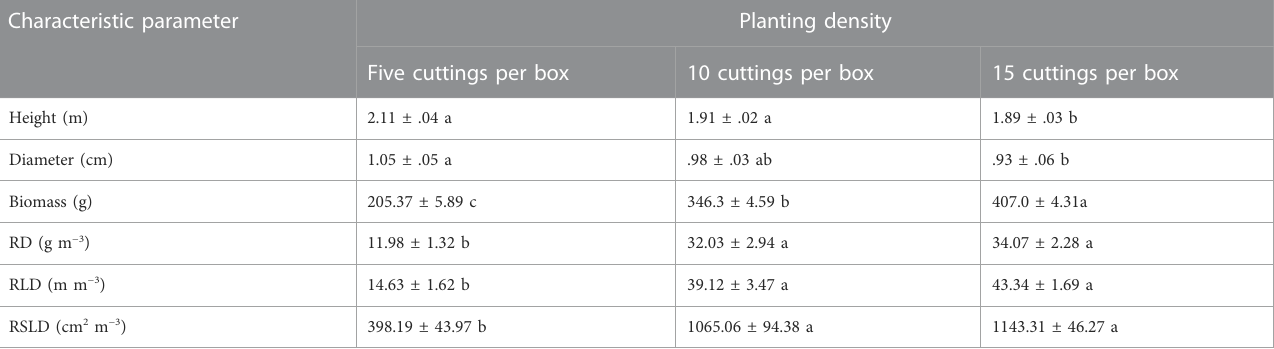
Note: RD, root density; RLD, root length density; RSAD, root surface area density. Different lowercase letters in the same row means signi fi cant differences at p < .05.